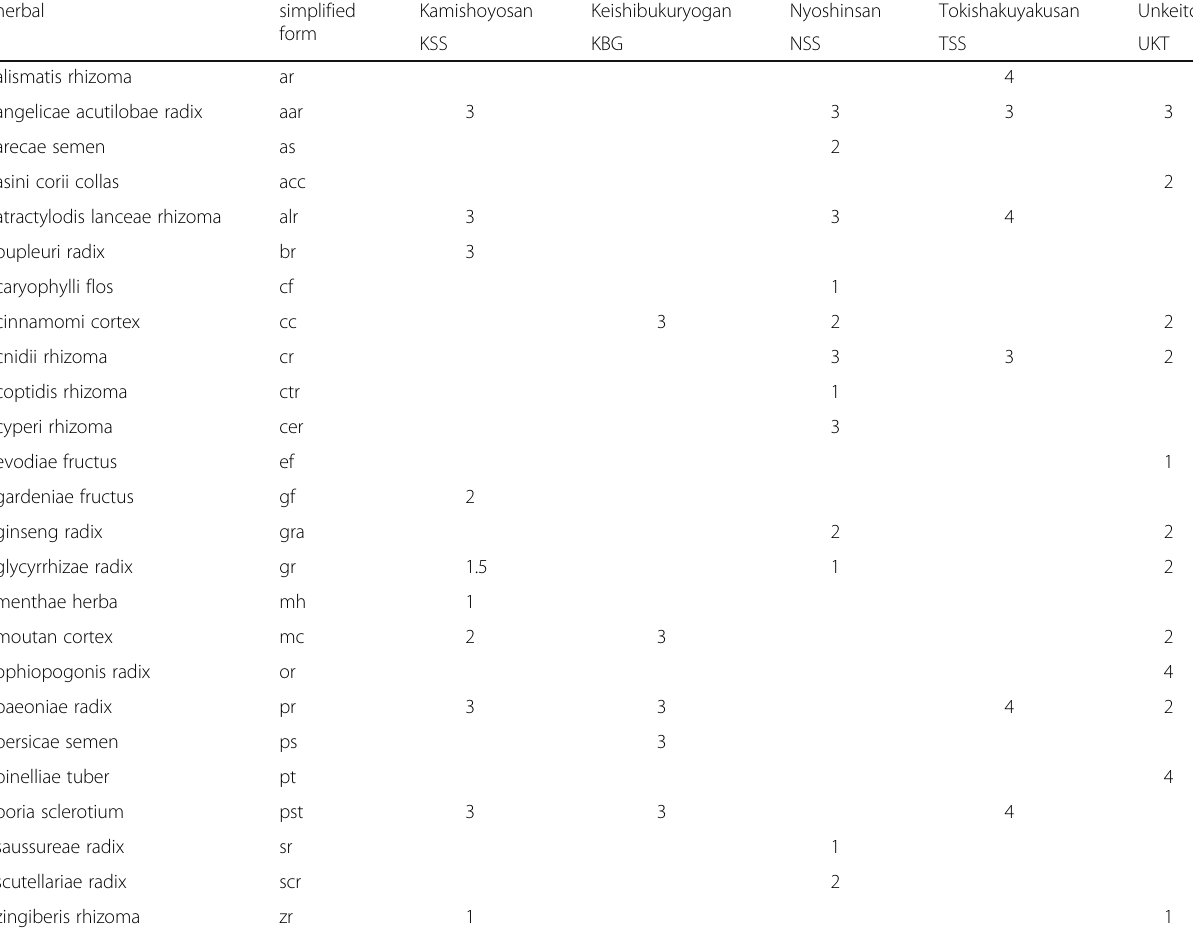
Table 1 The mass ratio of crude drugs in the Japanese herbal medicines